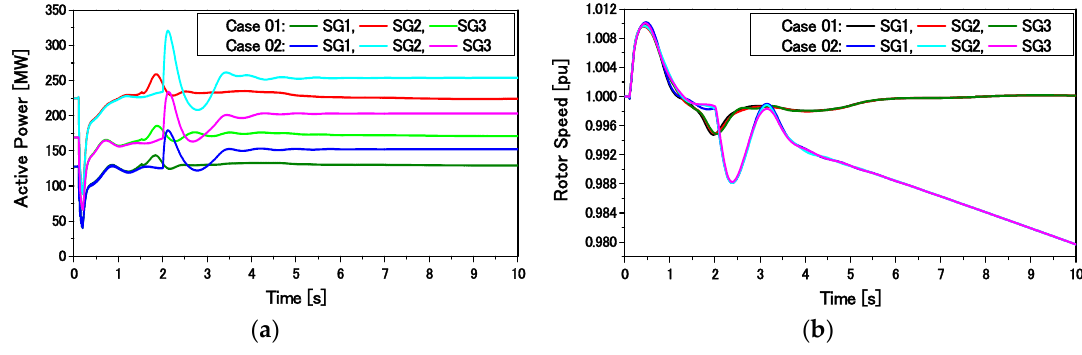
Figure 29. Individual responses of conventional SGs: ( a ) active power; ( b ) rotor speed.